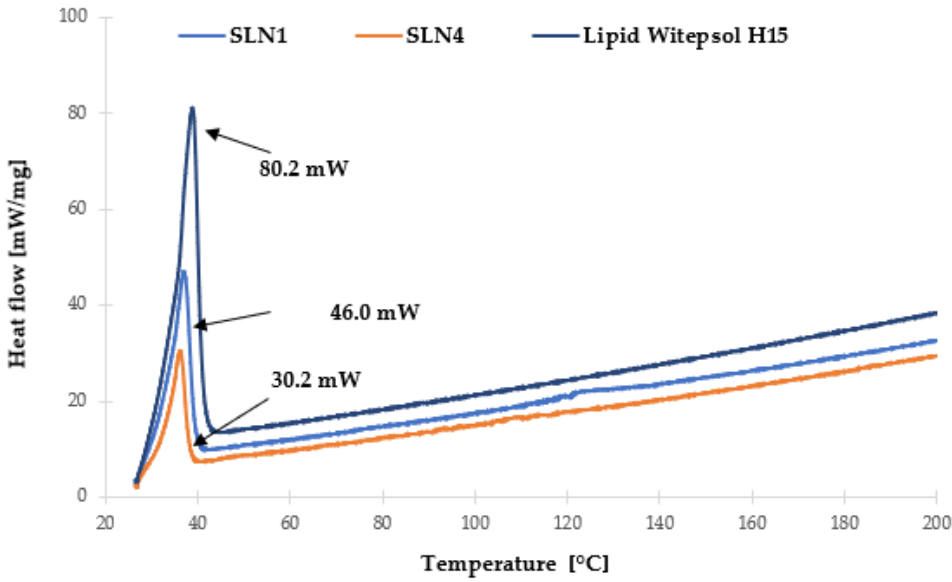
Figure 6. Comparison of DSC thermograms recorded during heating from 25 to 200 °C of synthesized SLNs and Witepsol ® H15 lipid.